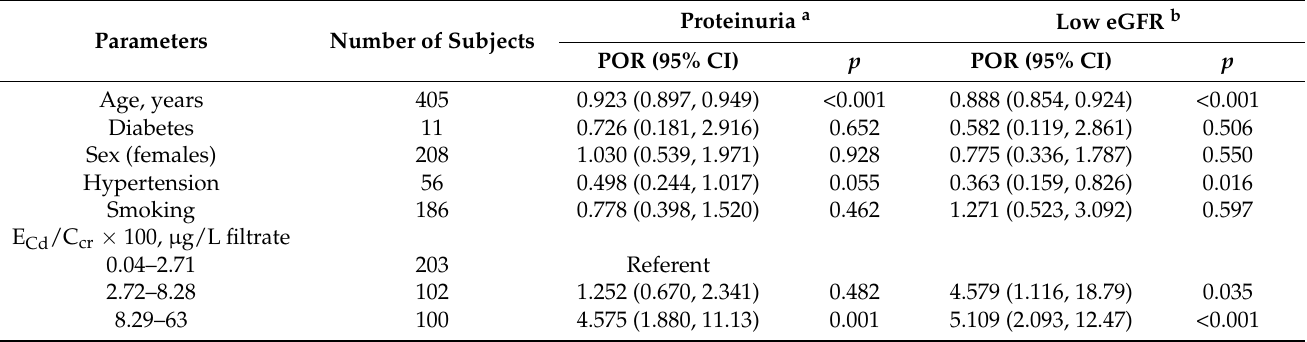
Table 4. Prevalence odds ratios for proteinuria and low eGFR in relation to cadmium excretion and other